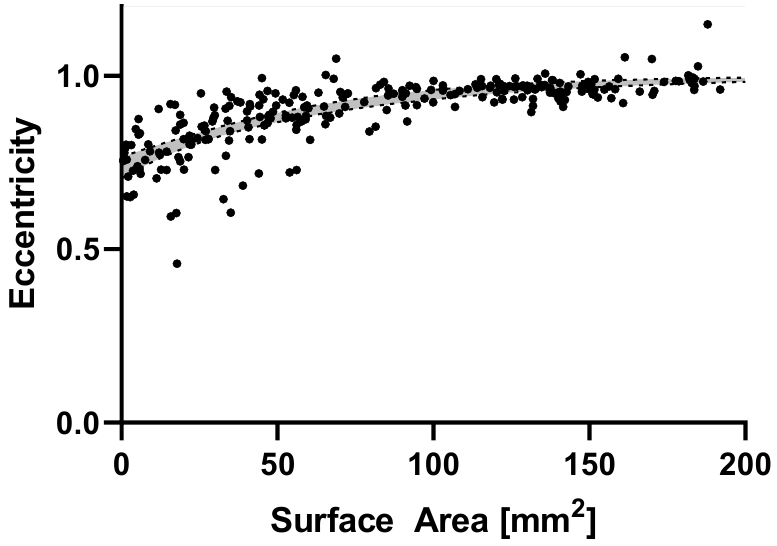
Figure 2. Wound shape eccentricity as measured by the ratio of circular radii estimates determined from area and circumference, respectively, for corresponding wound size (mm 2 ). Black dots represent these values forall timepoints are shown indicating a well-controlled wound shape of the experimental data as can be seen by the narrow mean prediction bands at the 95% confidence interval (grey) of exponential regression lines.